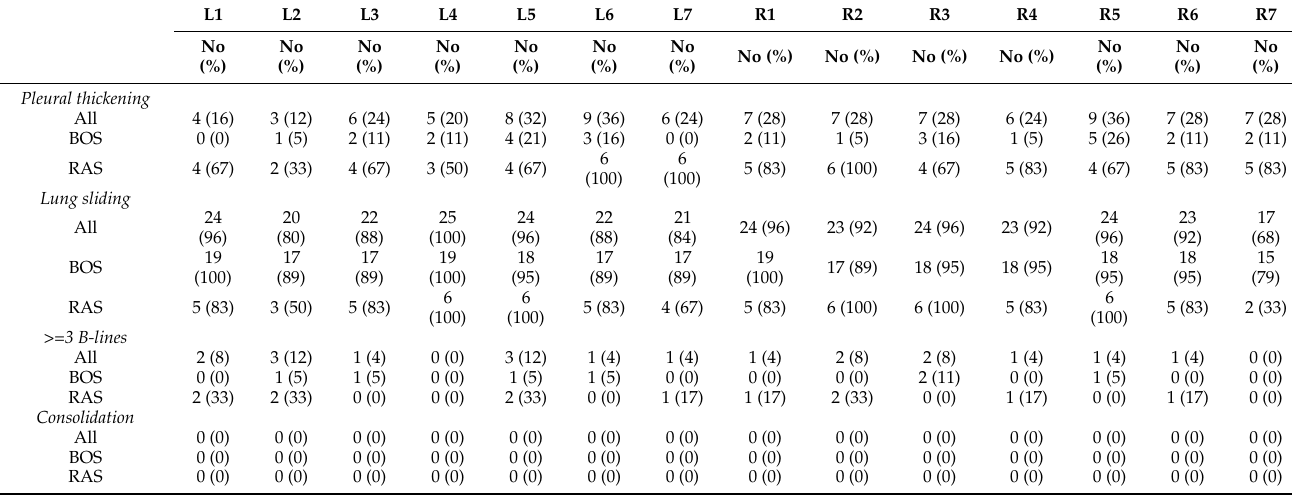
Table 2. Specific LUS findings according to LUS scanning zones and stratified corresponding to all, BOS, and RAS patients. L1